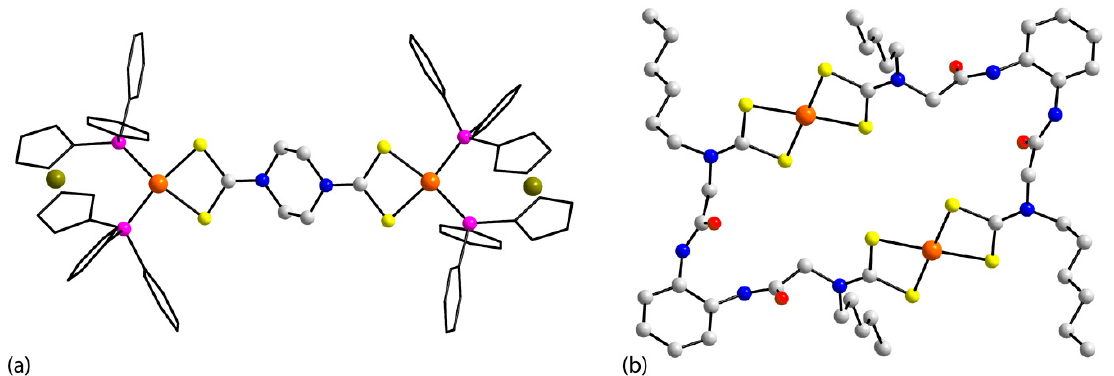
Figure 4. The di-nuclear molecules of ( a ) {[(dppf)Ni] 2 (L 2 )} 2+ in 6 and ( b ) Ni 2 (L 4 ) 2 in 8 . Additional colour code: dark-yellow, iron. The carbon atoms of the dppf molecules are illustrated in stick mode.